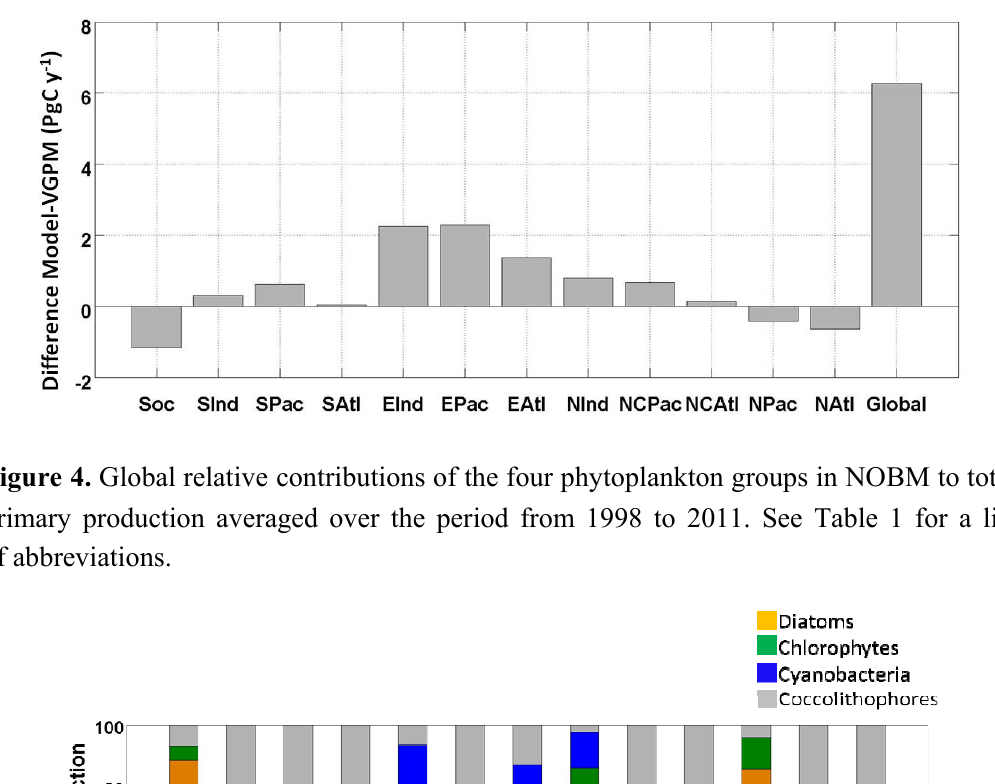
Figure 3. Difference between total primary production from NOBM and VGPM for the 12 basins and globally, averaged over the period from 1998 to 2011. See Table 1 for a list of abbreviations.